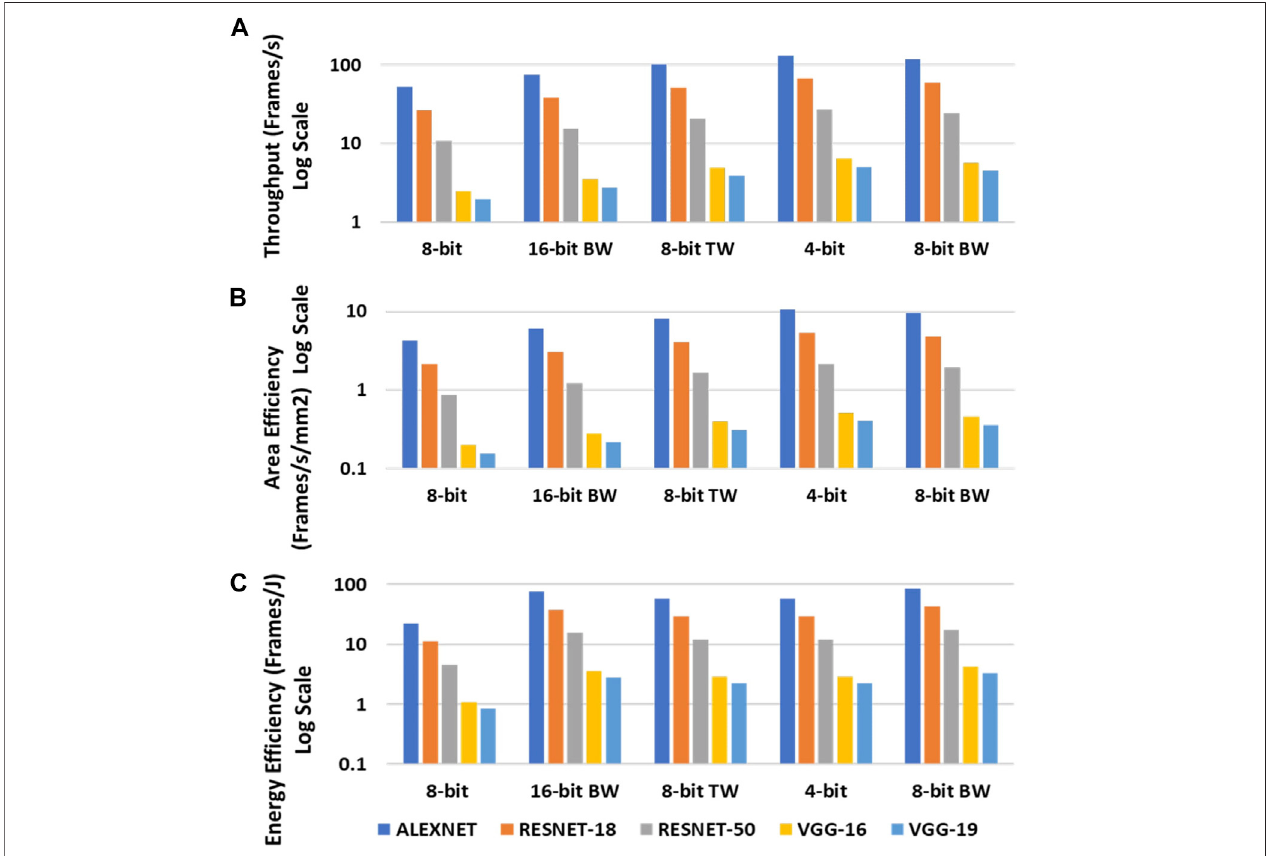
FIGURE 12 | Throughput (A) , Area-ef fi ciency (B) and Energy ef fi ciency (C) for CIDAN-XE, for CNN networks of varying bit-precision.